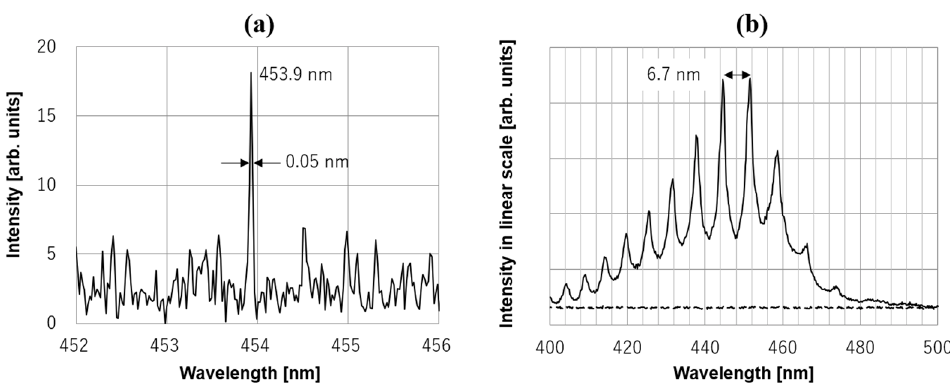
Figure 5. Spectra obtained from the all-dielectric-DBR GaN-based VCSEL above and below the threshold current (18 mA). Spectrum ( a ) was obtained at 20 mA and shows a single longitudinal mode at 453.9 nm and a half width at maximum of 0.05 nm. The latter value is equivalent to the resolution limit of the apparatus used to acquire the data (ADCMT8341). Spectrum ( b ) was acquired at 10 mA using a different spectrum analyzer (Ocean Optics USB4000) and shows a mode spacing of 6.7